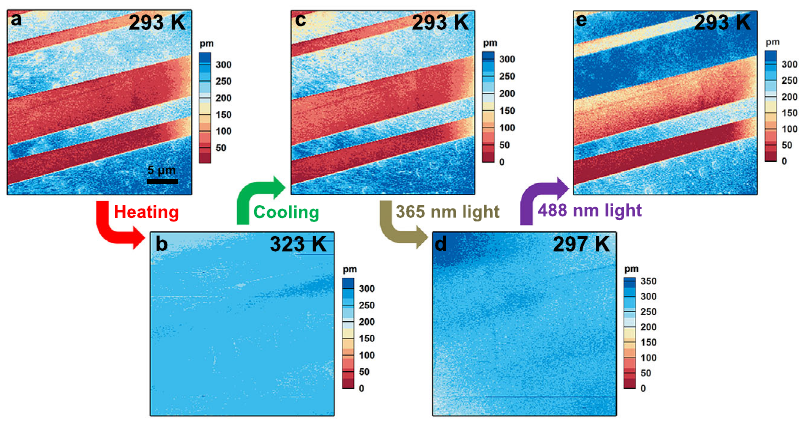
Fig. 4 Ferroelectric domains change by heat and light. Consecutive images showing erasure and recurrence of stripe domains in SA-NPh-( S ) thin- fi lm via both thermal treatment and light irradiation. The red and blue regions indicate the two different polarization-oriented states of ferroelectric domains. Domain patterns for SA-NPh-( S ) thin- fi lm a at the initial state, b after heating to the Phase II and c cooling down to the room temperature, subsequently d after 365 nm UV light irradiation, and e after 488 visible light